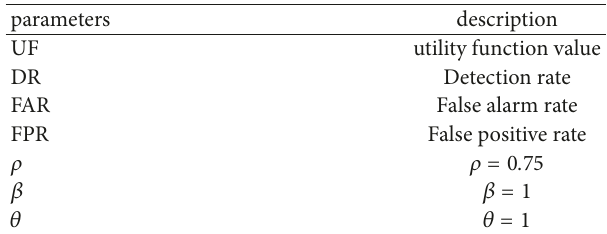
Figure 4: EXata sensor network simulation. Table 1: Utility function